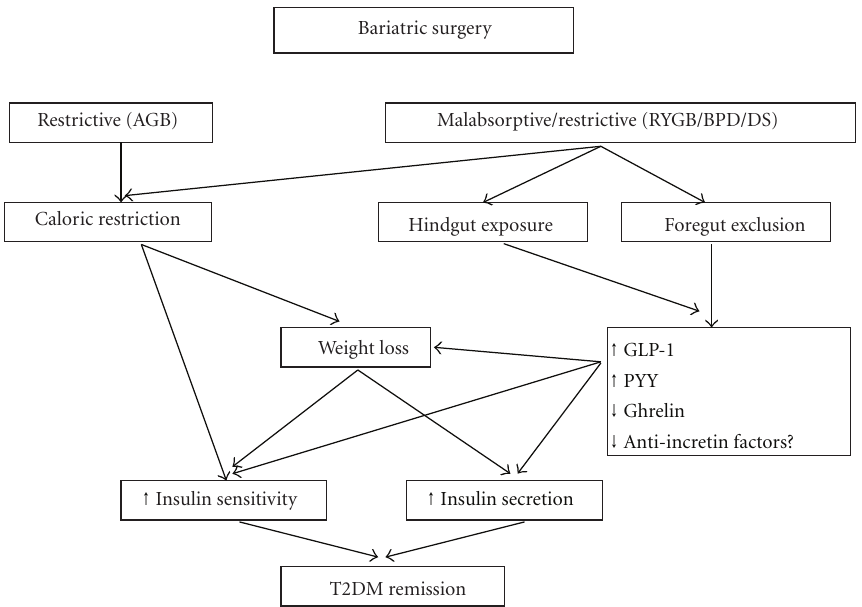
Figure 8: Proposed model for mechanisms of T2DM resolution after bariatric surgery (simplified from [32]).